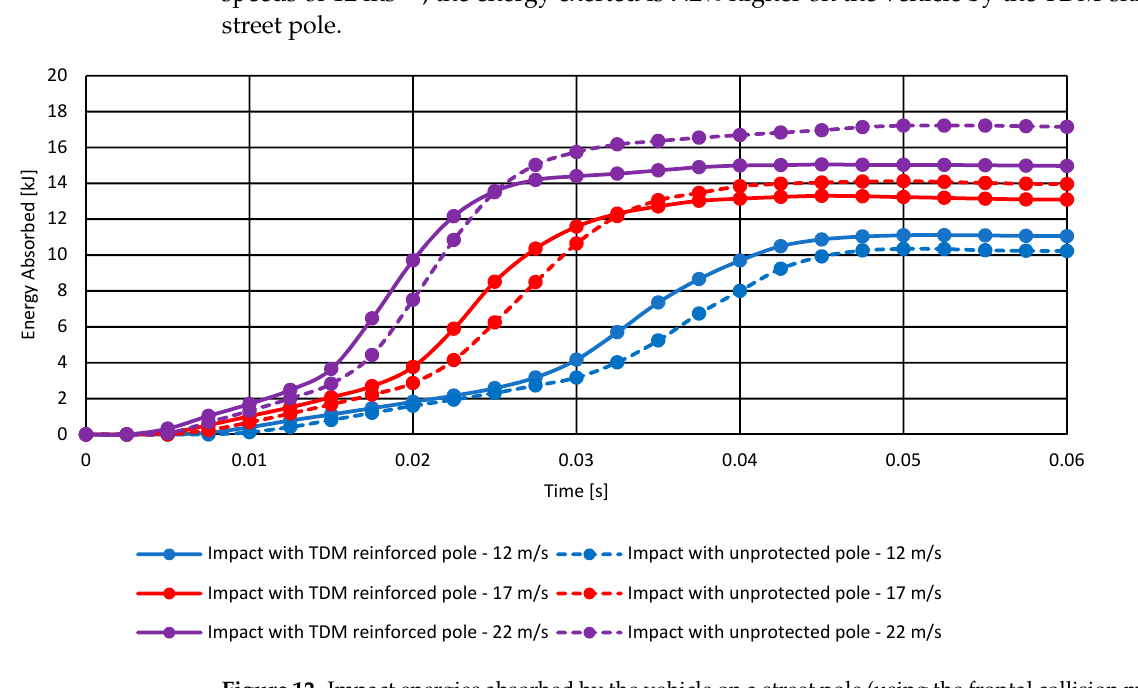
Figure 11. Impact energies were absorbed by the street pole (one as a bare street pole and the other shielded by TDM material of 35 mm) when collided by the vehicle through a corner collision sce- nario at speeds of 12 ms − 1 , 17 ms − 1 and 22 ms − 1 .